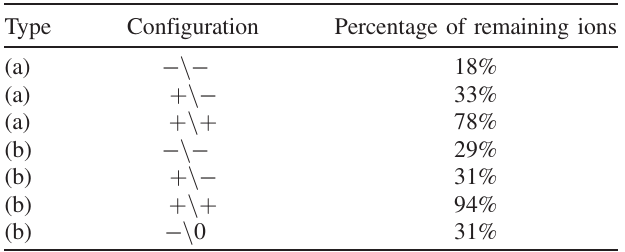
TABLE II. Percentage of remaining ions after 10 000 bunch-ion interactions in a 20 cm straight section. The configuration indicates the electrode polarization, the first sign corresponds to the upper electrode and the second one for the lower electrode. Respectively, þ stands for U ¼ 0 . 5 kV, — for U ¼ − 0 . 5 kV and 0 for U ¼ 0 V. From NUAGE simulations with CO þ ions and N